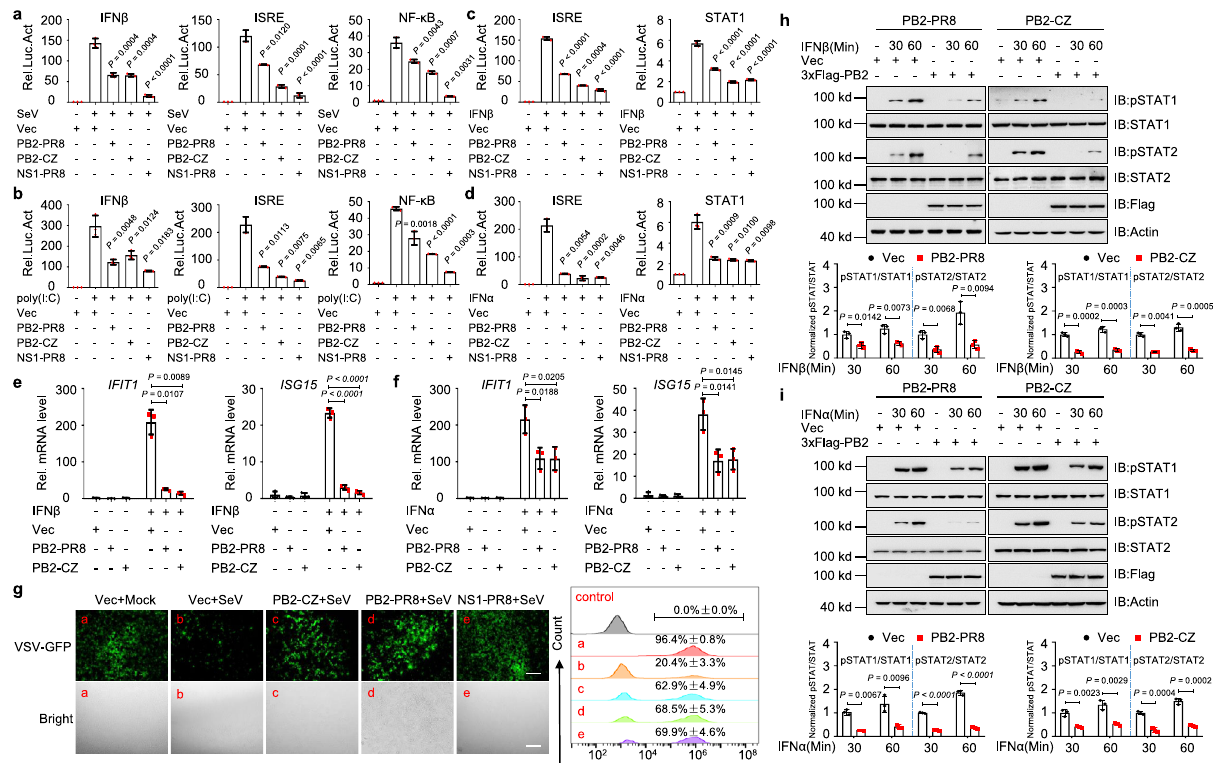
Fig. 1 |IAV PB2 proteininhibitsIFNsignalingpathway.a , b Luciferase activityin HEK293T cells transfected with IFN β promoter, ISRE or NF- κ B luciferase reporter, Renilla luciferase plasmid, and PB2 plasmids (including NS1-PR8 and empty vector [Vec]werechosen aspositiveand negativecontrols,respectively)and treatedwith SeV ( a ) or poly(I:C) ( b ) ( n =3 biologically independent samples). c , d Luciferase activity in HEK293T cells transfected with ISRE or STAT1 promoter-luciferase reporter plasmid, Renilla luciferase plasmid, and PB2 plasmids and treated with IFN β ( c ) or IFN α ( d ) ( n =3 biologically independent samples). e , f qPCR analysis of IFIT1 and ISG15 mRNAinA549 cellstransfected with PB2 plasmidsand treated with IFN β ( e )orIFN α ( f );mRNAresultsarepresentedrelativetothoseofuntreatedcells transfected with a control plasmid ( n =3 biologically independent samples).